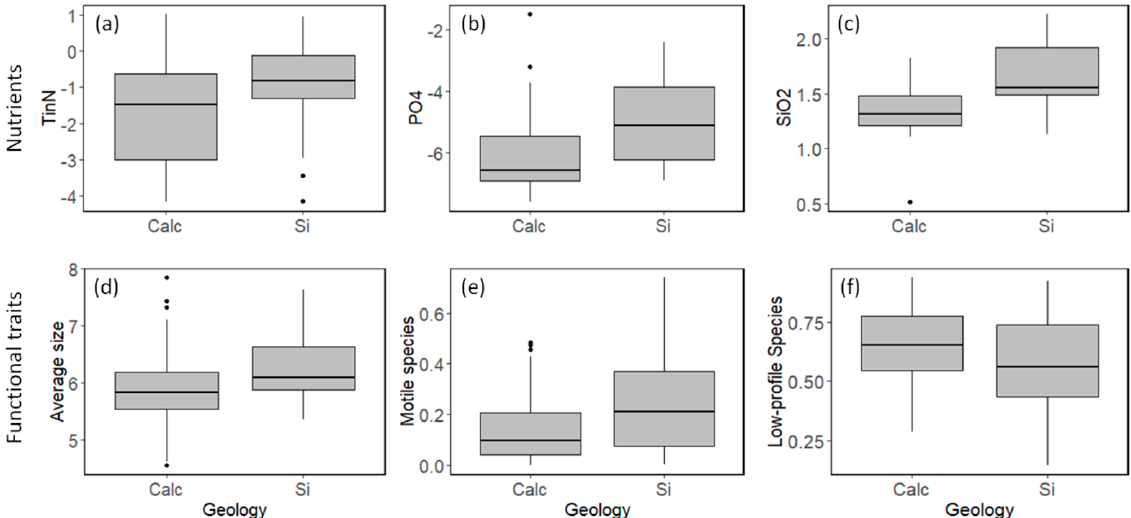
Figure 2. Difference between nutrient concentrations: ( a ) total inorganic nitrogen; ( b ) orthophos- phates; ( c ) silicates and species functional traits; ( d ) average size in the assemblage; ( e ) relative abundance of motile species; ( f ) relative abundance of low-profile species between calcareous and siliceous substrates. Y-axis in ( a – d ) is ln-transformed.